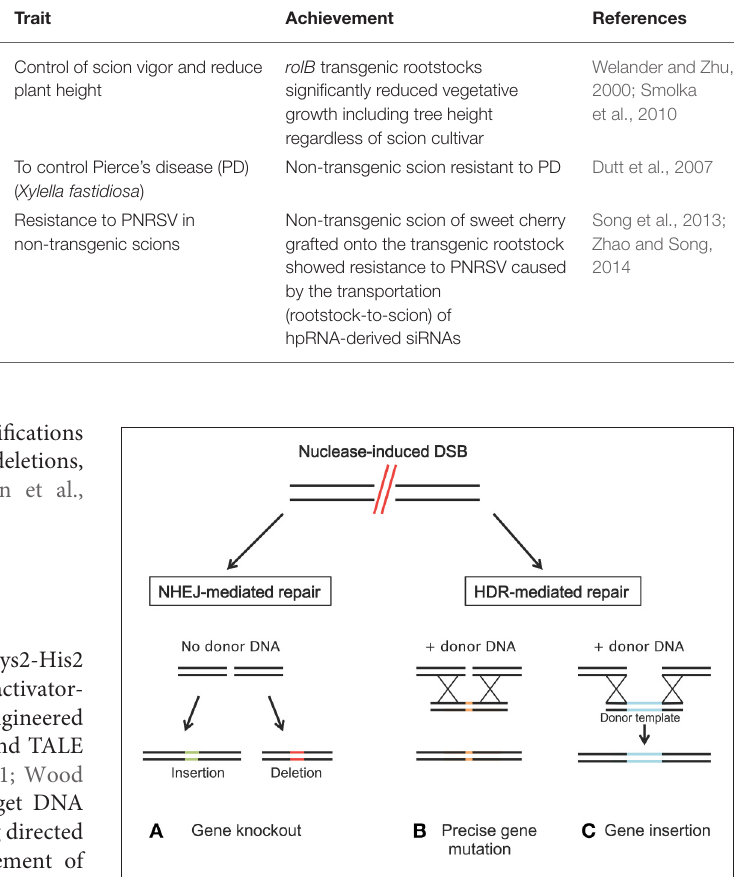
FIGURE 3 | Induced double strand breaks (DSBs) of the target DNA by nucleases can be repaired by either non-homologous end-joining (NHEJ) or homology directed repair (HDR). (A) NHEJ usually leads to gene knockout by the insertion (green) or deletion (red) of random base pairs. (B) If a donor template, that shares regions of homology to the sequence next to the DSB is available, HDR can introduce precise gene modification or (C) specific nucleotide/gene